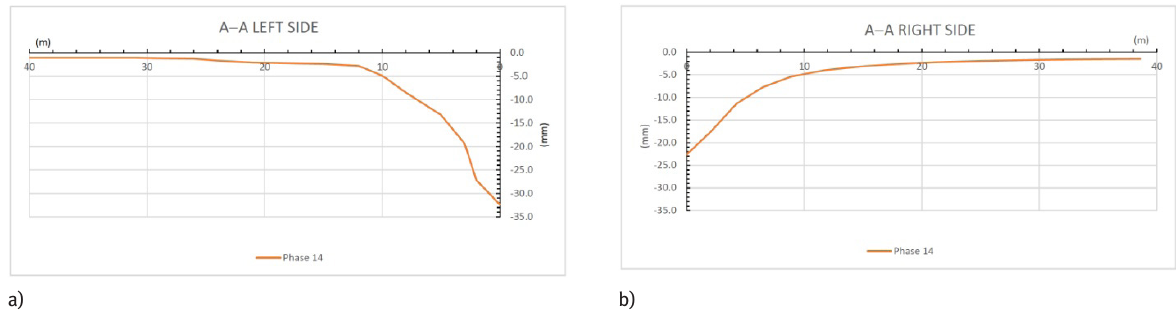
Figure 13: Phase 14 of the implementation – application of the full-service load; graph of vertical displacements of the land surface in the A–A cross section: a) on the left, b) on the